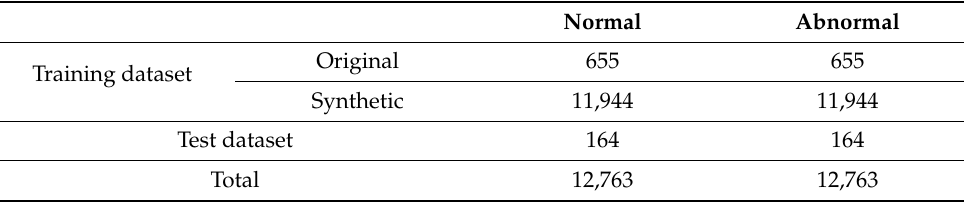
Table 1. Classification of images in the